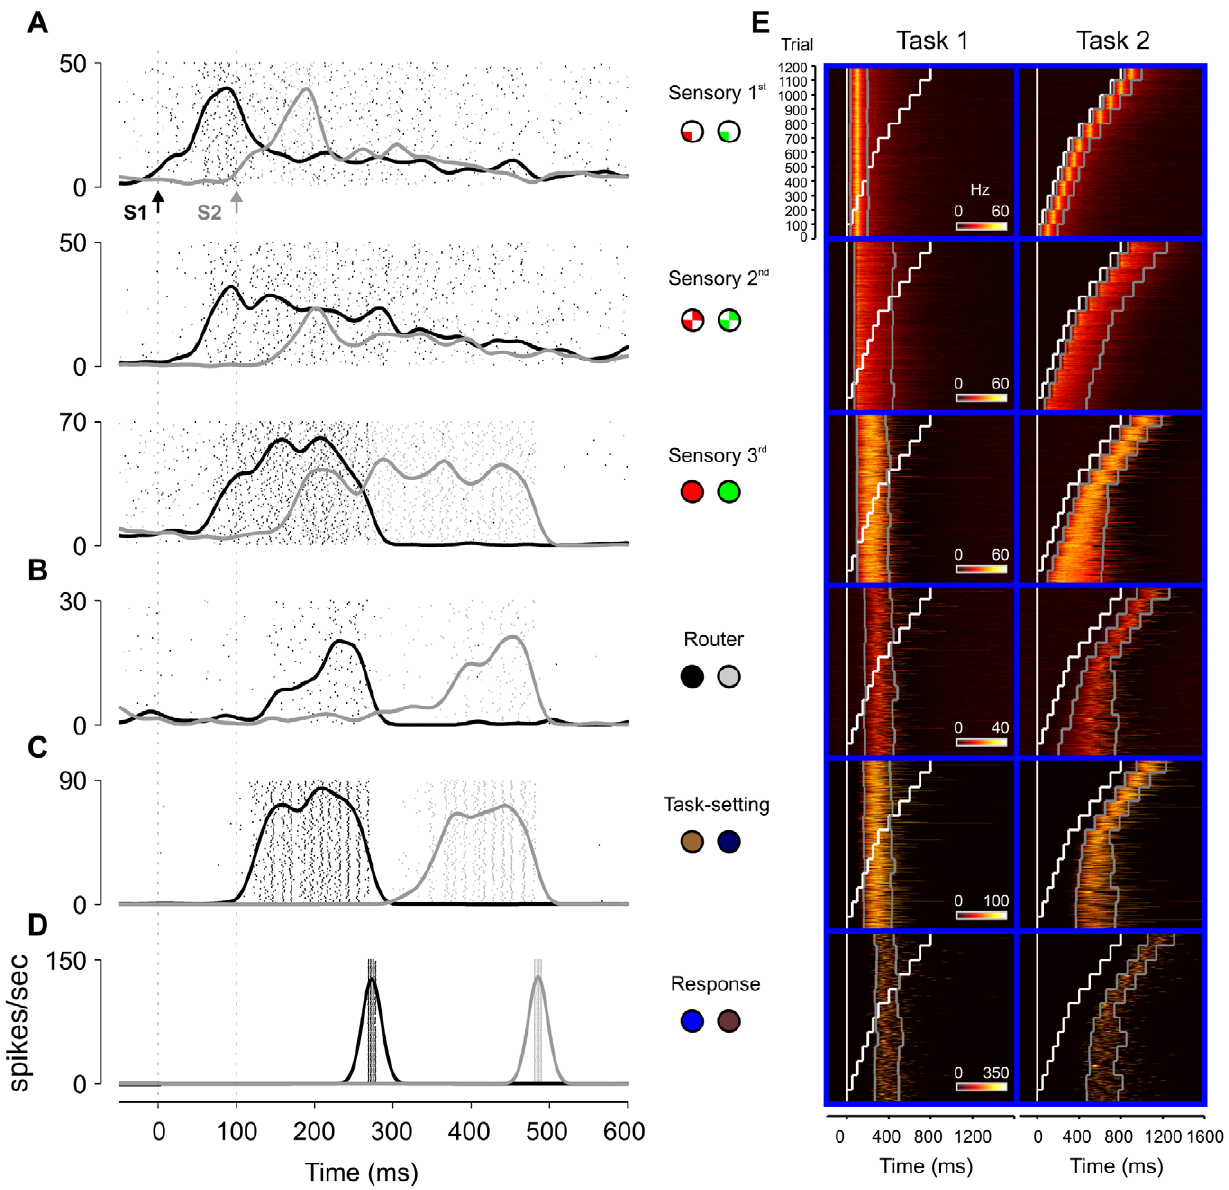
Figure 3. Neural activations during dual-task performance. (A–D) Firing rates in the dual-task condition inside the interference regime (SOA=100ms). Each panel is defined as in Figure 2, with black and grey lines corresponding to populations from the first and second tasks, respectively. The specific populations plotted are indicated with colored circles, following the notation of Figure 1 (the circles to the left correspond to the first task). (E) Firing rates are plotted for 1200 trials (100 at each SOA) for neurons responding to the first and second tasks (left and right columns in each panel, respectively). White lines indicate the onset of the stimuli of task 1 and 2, and grey lines mark the specific times at which the average activity at each SOA crossed 1/3 of its peak value. In early sensory areas, both the onset and offset of the response are time-locked to stimulus presentation at short SOA, thus indicating a completely parallel mode of activation. In contrast, task-setting, response and integrating neurons show a highly serial activation profile. The onset and the offset of these neurons for task 2 in the interference regime are locked to the end of the corresponding process of task 1. In the non-interference regime, however, the onset of these neurons is locked to stimulus presentation. Higher sensory modules showed a hybrid profile, indicating that the same neuron can be involved in a phasic parallel response and also exhibits sustained activity until the response. In the interference regime, the onset of these neurons is locked to the presentation of the stimulus, but the offset show a sequential locking to the ending of task 1. Firing rates were calculated by filtering the instantaneous population firing rate with an exponential causal kernel with a time constant of 20 ms.